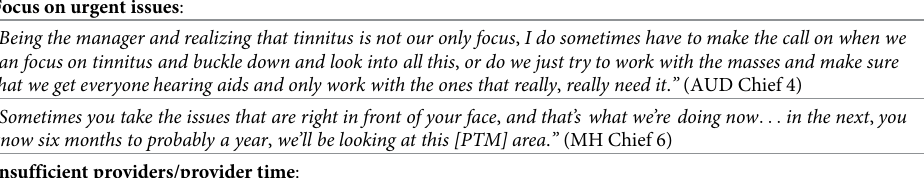
Table 1. Prioritization barriers (illustrative